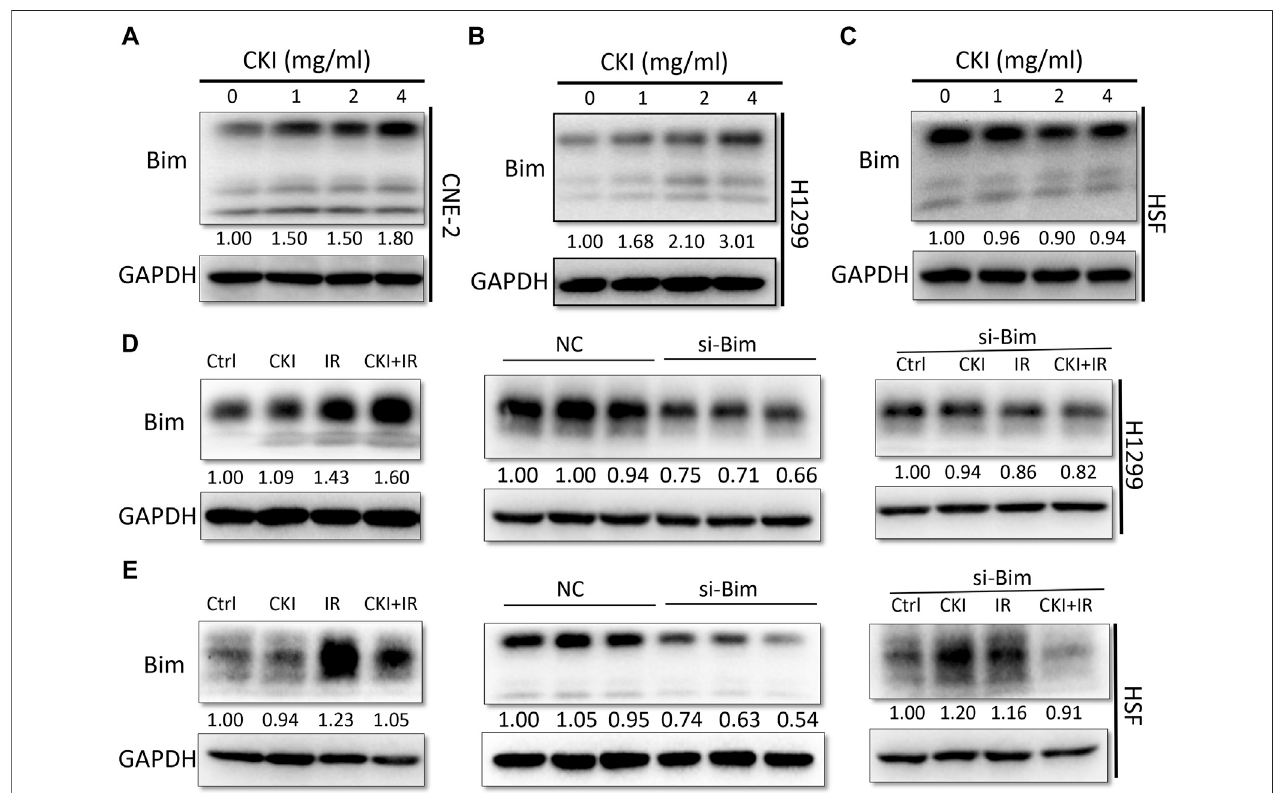
FIGURE 5 | Inhibiting Bim attenuated the differential Bim expression trends caused by the combination of CKI and IR. (A – C) Cancer cells (CNE-2 and H1299) and HSF cells were treated with increased dose of CKI. (D – E) Cancer cell H1299 and HSF cells were treated with CKI (4 mg/ml), IR (4Gy) and combination of CKI and IR, respectively. Transient transfection was performed to inhibit Bim expression by siRNA. Bim expression was evaluated using Western Blot. GAPDH was used as an external control. The results were measured by ImageJ